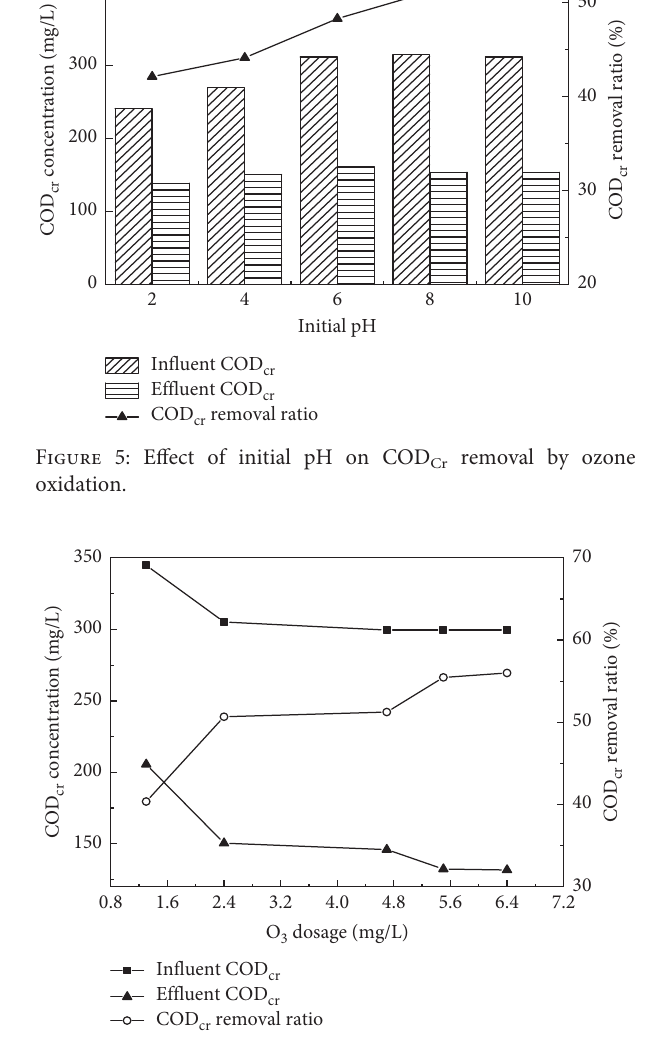
3 dosage on COD Cr removal by ozone